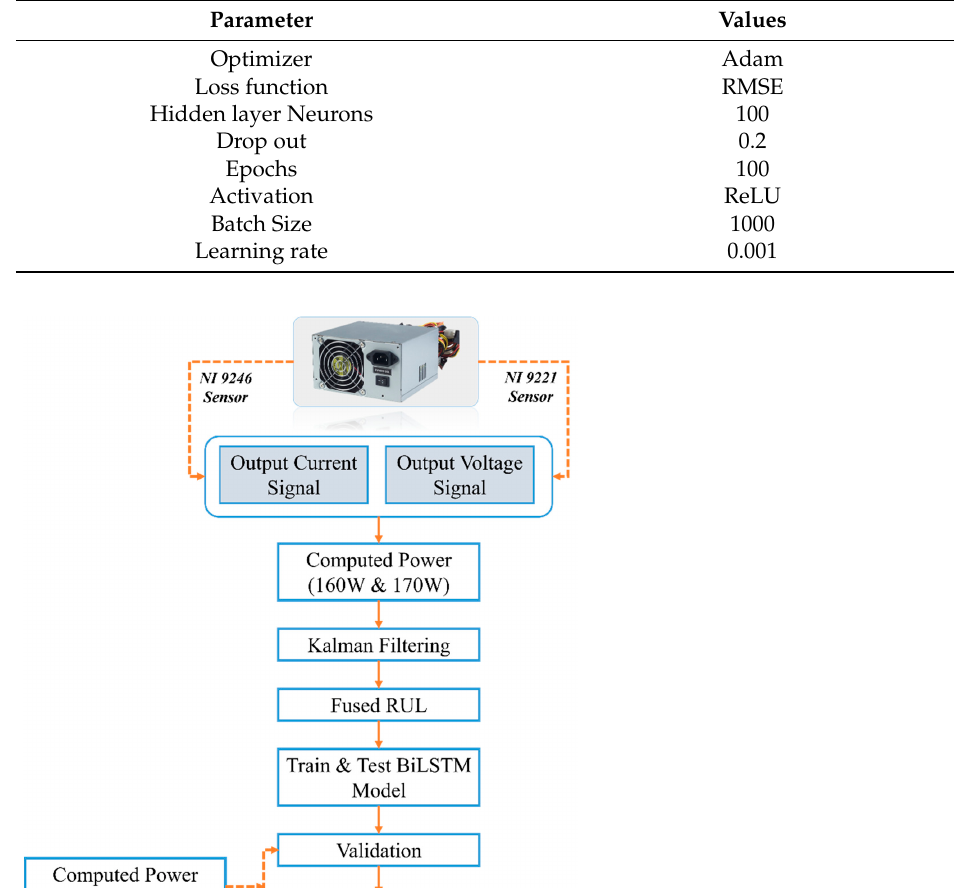
Table 1. BiLSTM Model Parameters.